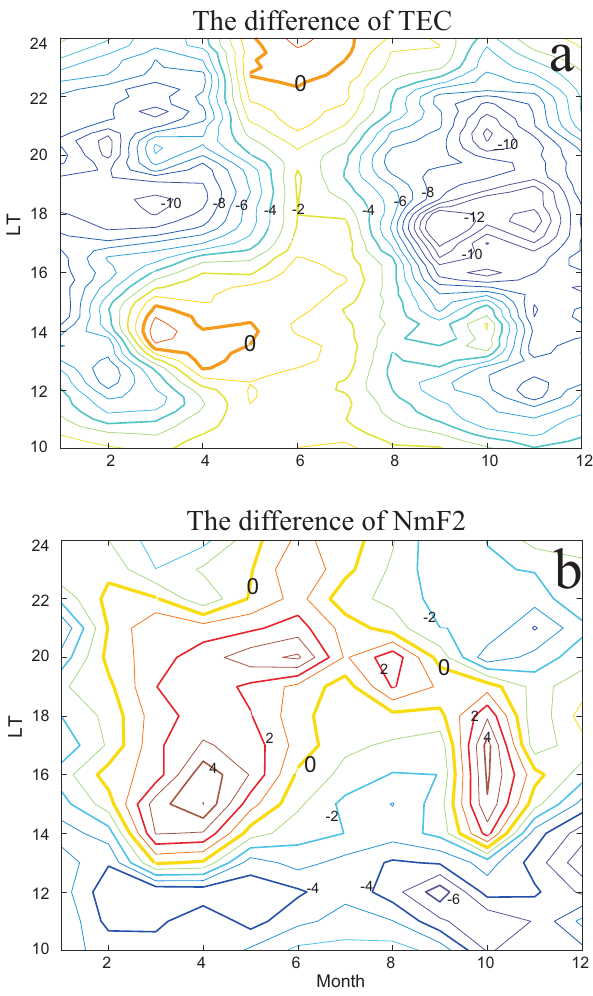
Fig. 10. (a) Contour map of the TEC differences between Guangzhou and Qiongzhong in 2004 (unit: TECu). (b) Contour map of the Nm F2 differences between Guangzhou and Haikou in 2004 (unit: 10 11 elm − 3 )